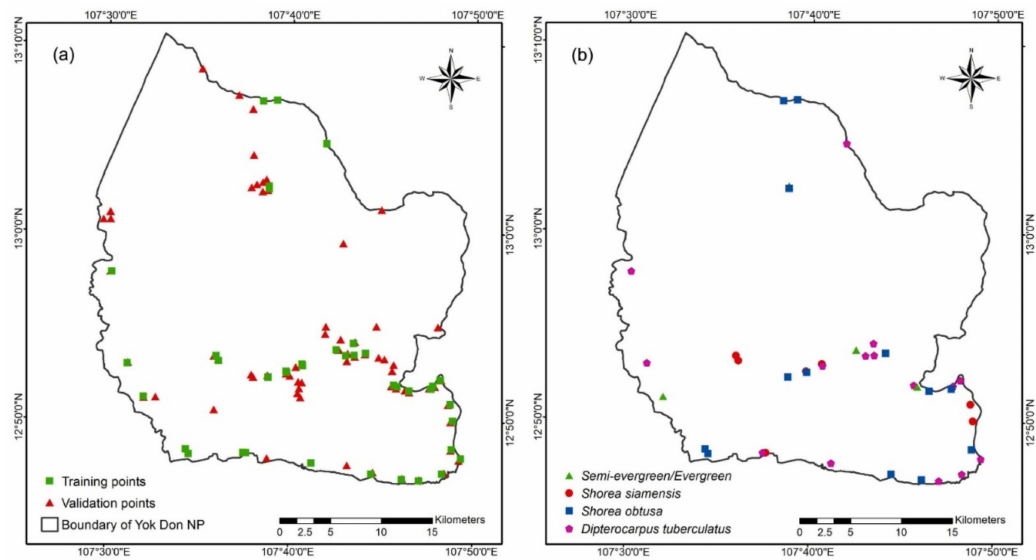
Figure 3. ( a ) Distribution of field survey data: ( a ) plots used for training are shown in green and plots used for validation are shown in red and ( b ) spatial distribution of the 39 field survey plots of the four types of deciduous forest used for